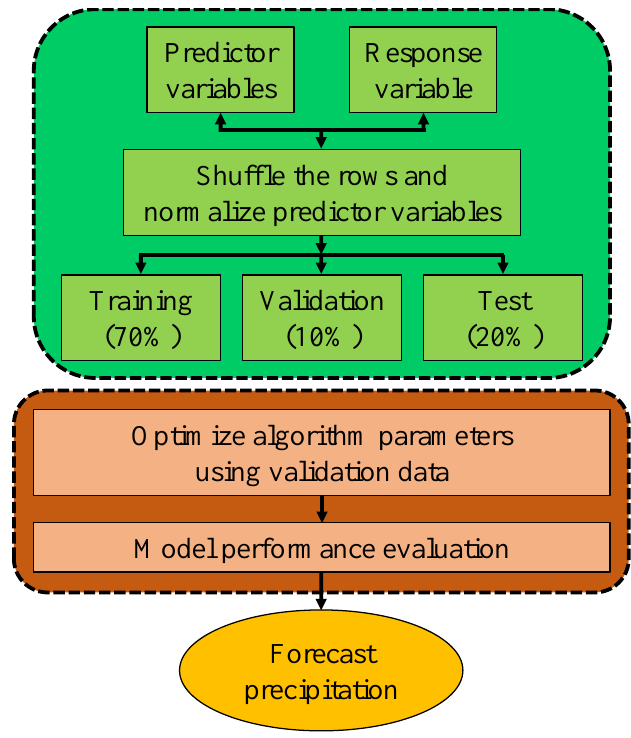
Figure 3. Schematic representation of the prediction process for this study.